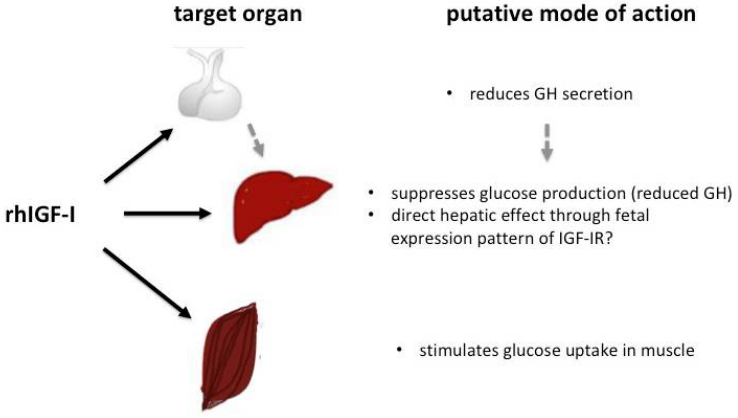
Figure 3. Putative effects of rhIGF-I on glucose homeostasis.